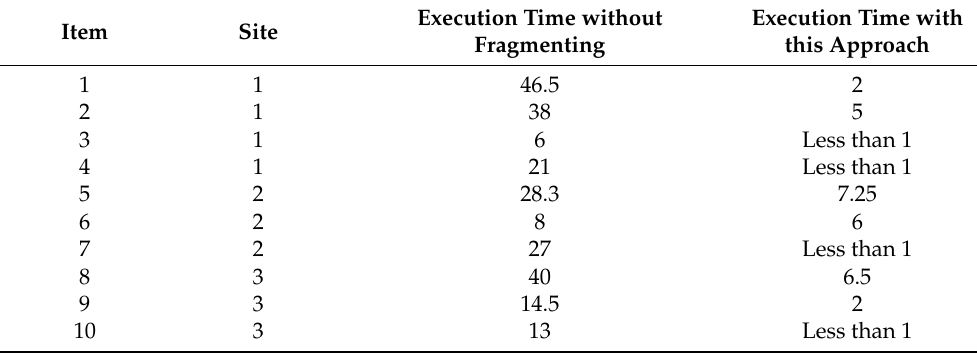
Table 8. Comparison of execution times using the items of operations in Table